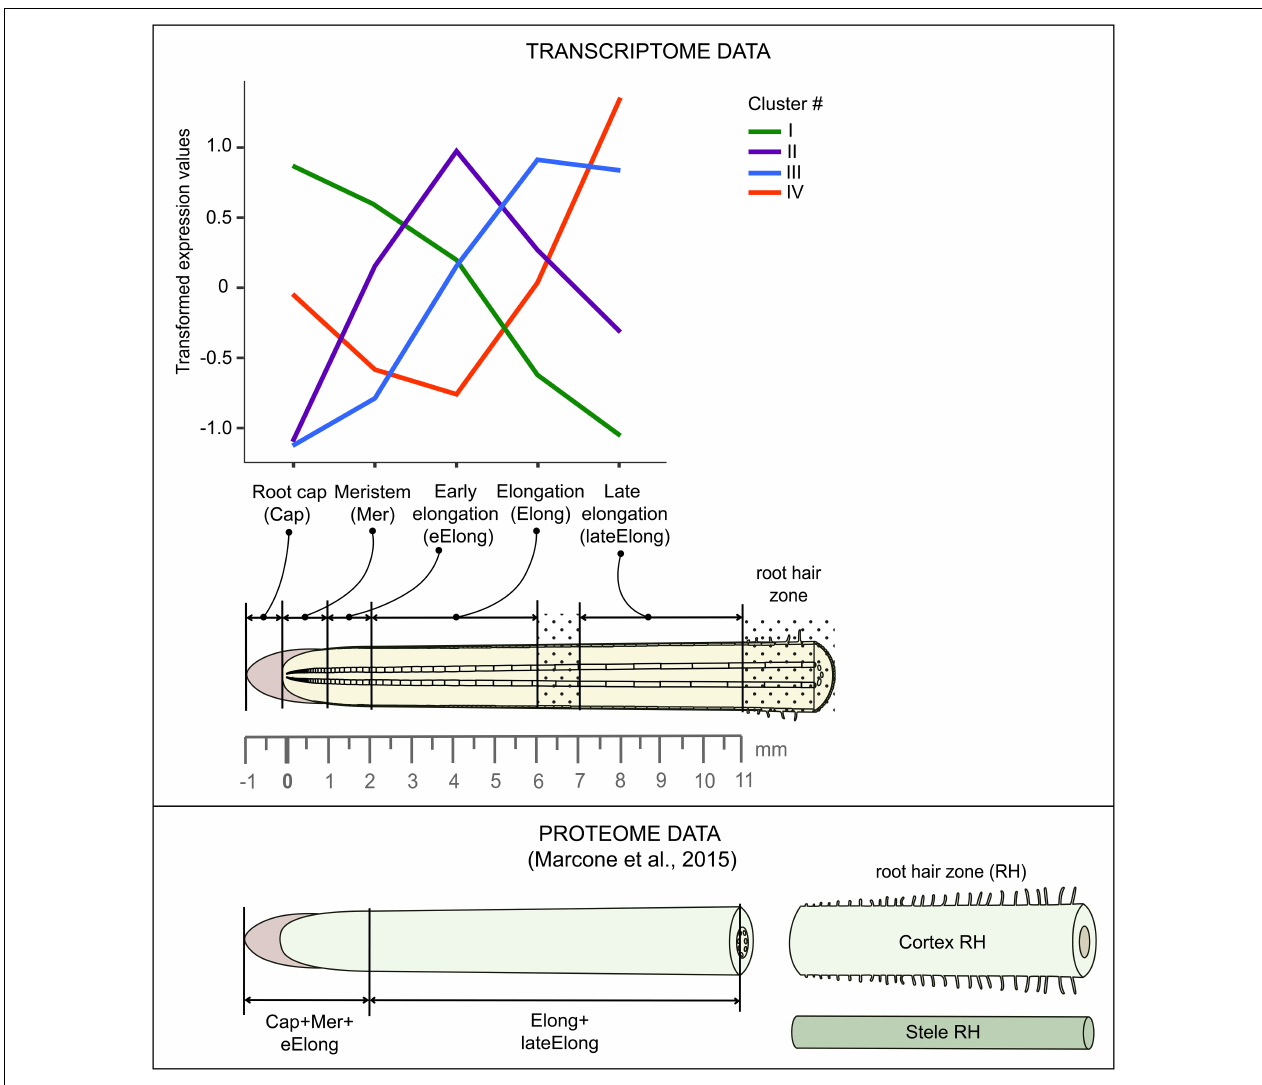
FIGURE 2 | Scheme of maize root sampling for transcriptome and proteome (Marcon et al., 2015) analyses and four clusters of GH transcript abundance obtained by cluster analysis. The dot painting indicates maize root zones that were not used for analyses in this